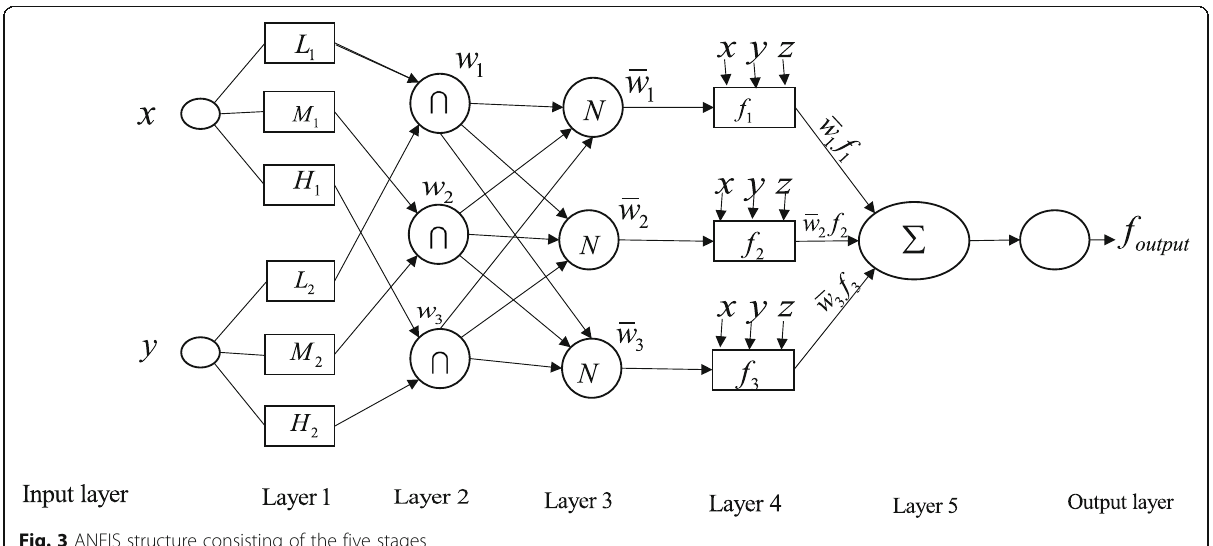
Fig. 3 ANFIS structure consisting of the five